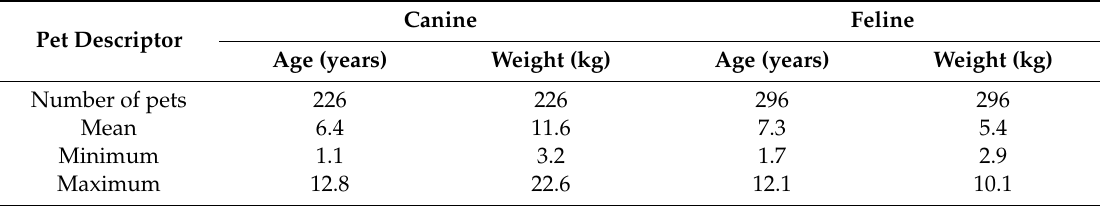
Table 1. Pet age and weight.